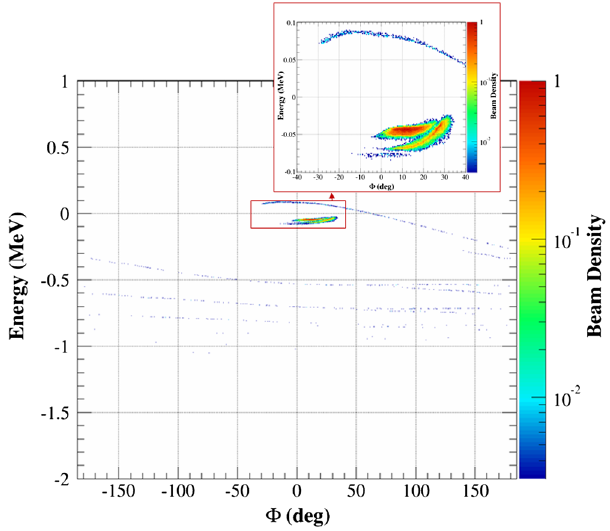
FIG. 18. Distribution of the losses in the linac brought back to the exit of the